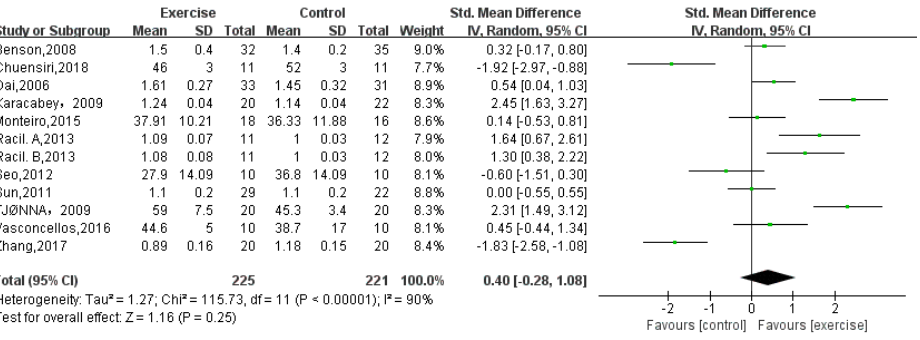
Figure 4. Forest plot of HDL-C.